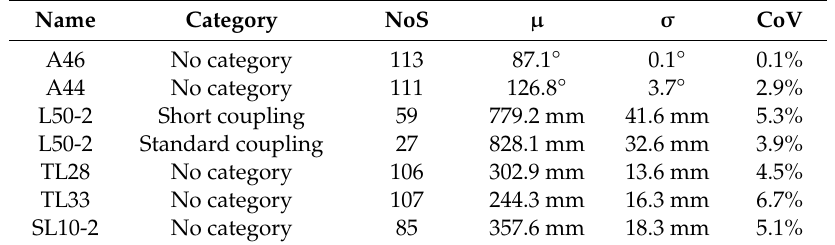
Table 1. Overview of the empirical values for the dimensional chain in the